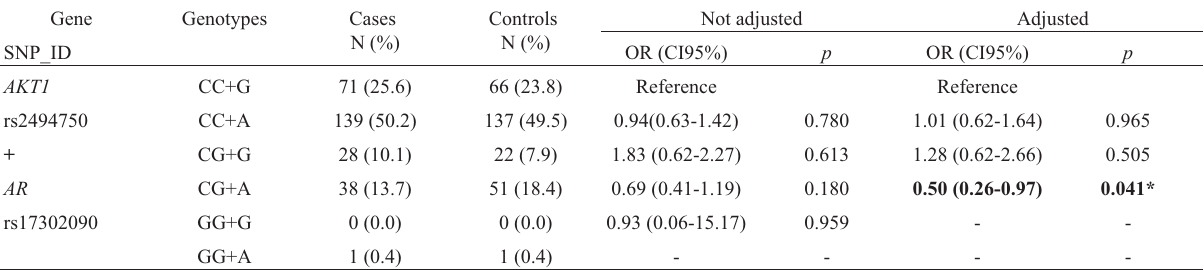
Table3 -Univariateandmultivariatelogisticregressionanalysisoftheassociationbetween AKT1 and AR genesinprostatecancerpatientsandcontrols. Gene